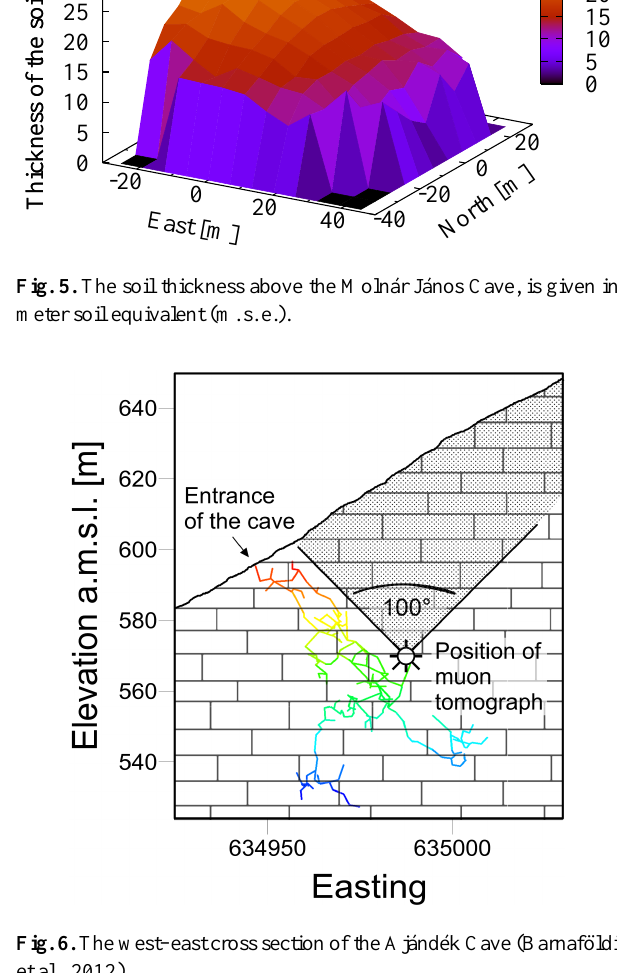
Fig. 6. The west–east cross section of the Aj´and´ek Cave (Barnaf¨oldi et al., Fig. 6. The West-East cross section of the Aj´and´ek Cave (G. G. Barnaf¨oldi et al. , 2012).